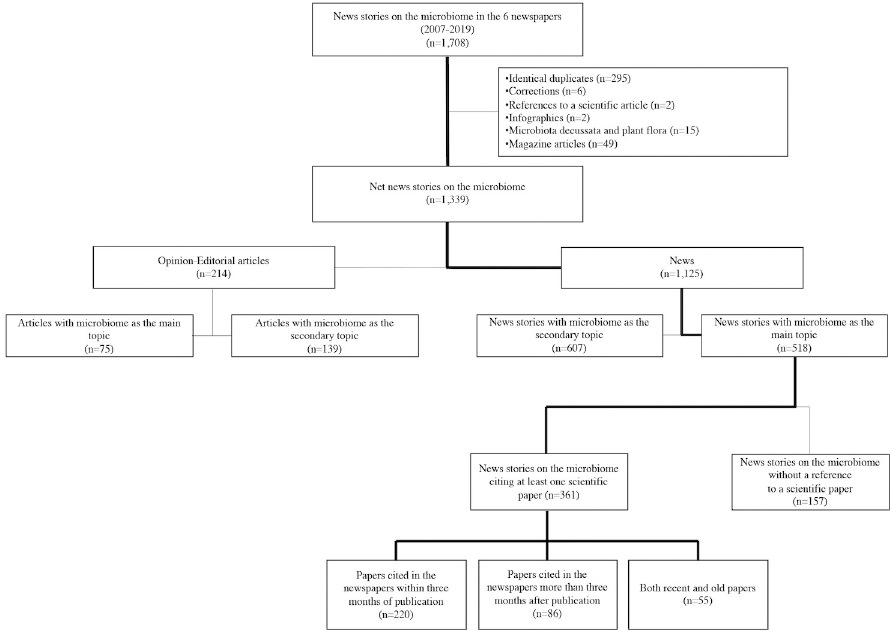
Fig 1. Process flow diagram of the categorization of news stories on microbiome